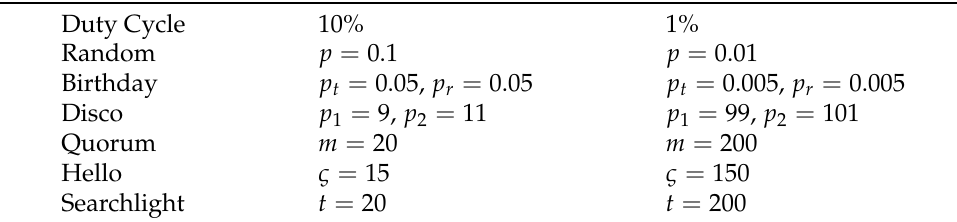
Table 2. Simulation parameters for 10% and 1% duty